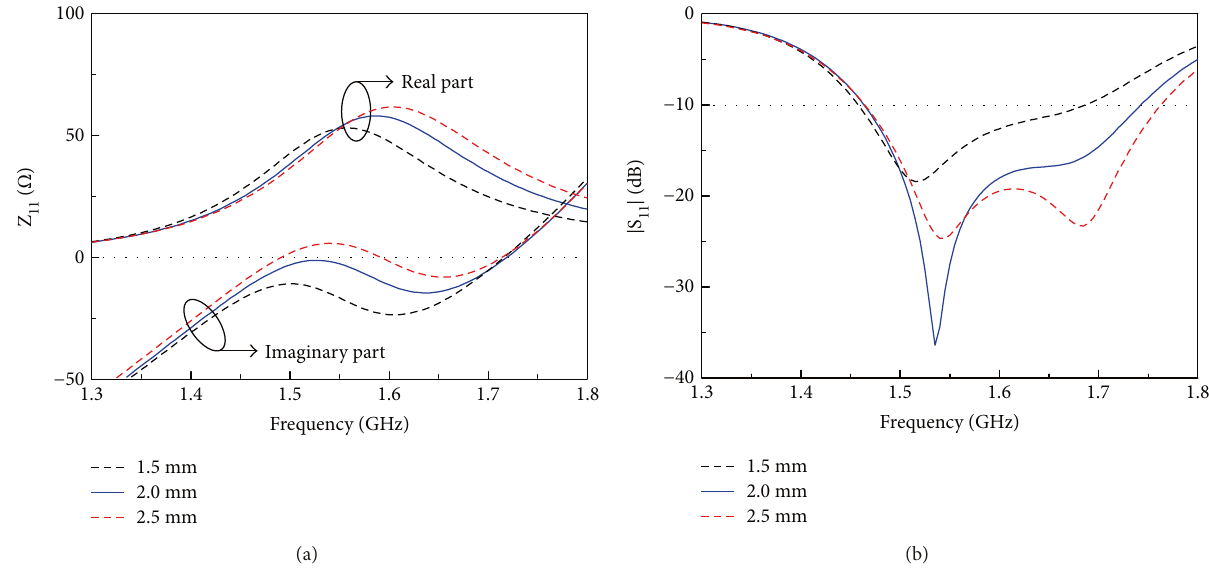
Figure 6: Simulated (a) input impedance and (b) |S between parasitic patches